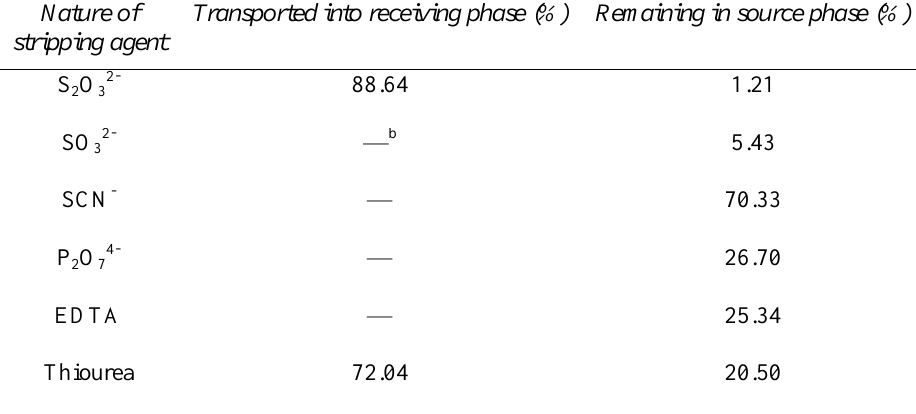
phase, 5 ml of 1.0×10 -3 M of different stripping agents at pH 3; time of transport, 4 hours. b The hyphenated symbols mean that the values are about